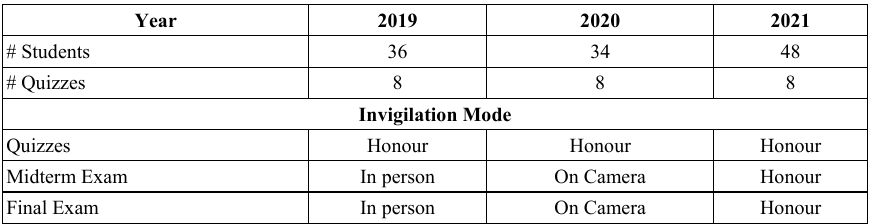
Table 1. The class size, the various assessments and their